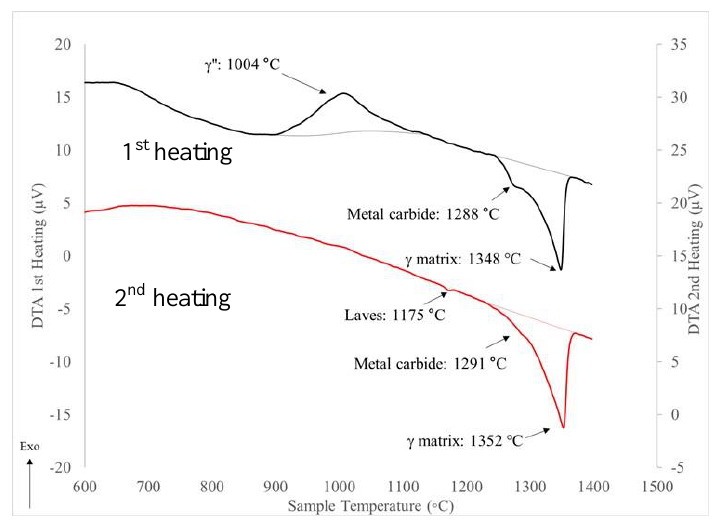
Figure 13. DTA heating cycles for FHT Inconel 718.